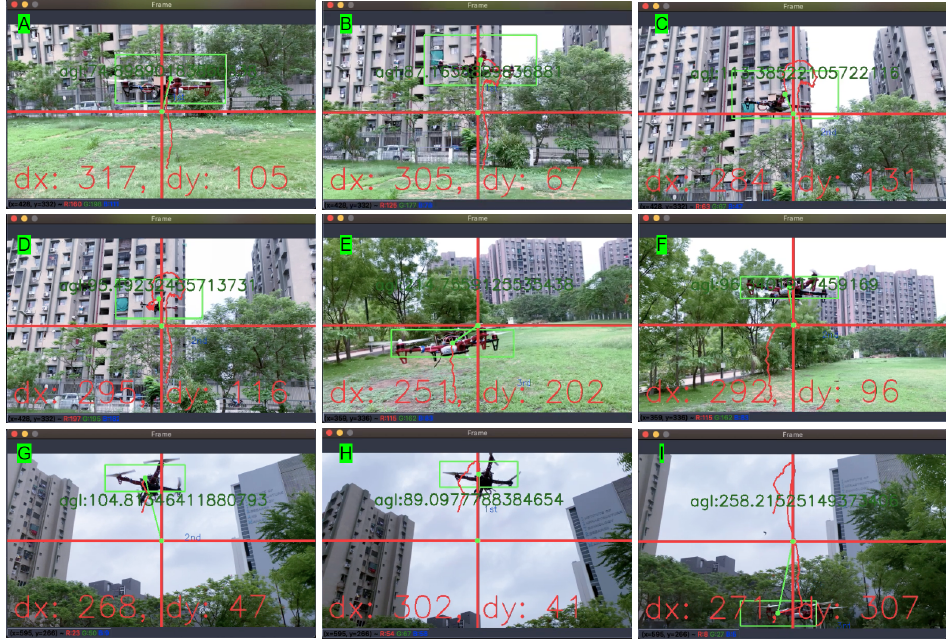
Figure 17. Airborne Object target Tracking (AOT) (drone to drone